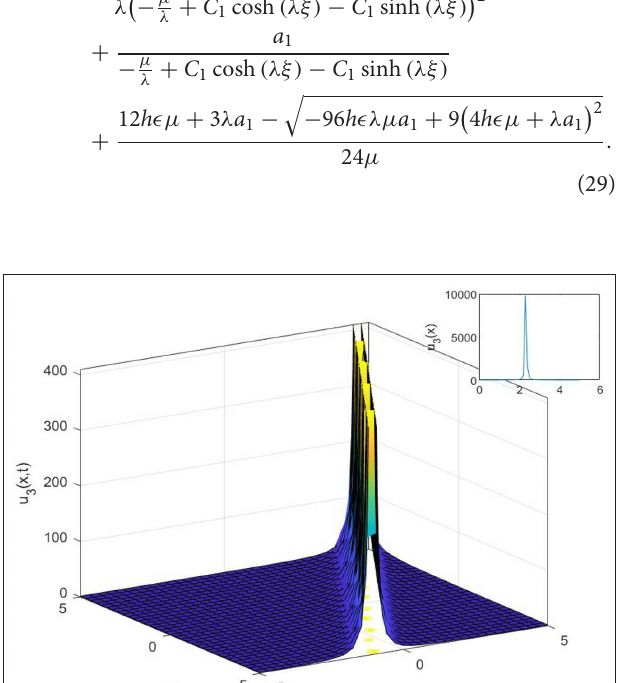
FIGURE 3 | The 3D, 2D, and contour surfaces of Equation (23) using k 2, α 5, λ 1.2, ǫ 6.6, C 1 2, and a 1 = = = = =